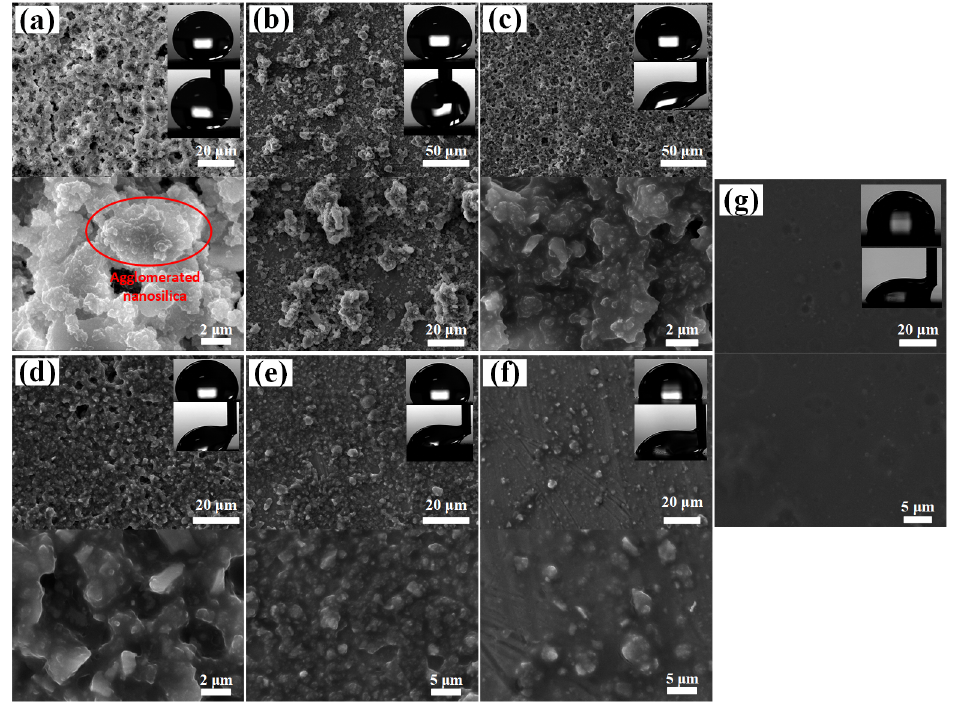
Figure 8. SEM images of the nano / microsilica-filled A-PDMS-modified epoxy coatings: ( a ) R n / m = 10:0; ( b ) R n / m = 8:2; ( c ) R n / m = 6:4; ( d ) R n / m = 4:6; ( e ) R n / m = 2:8; ( f ) R n / m = 0:10. ( g ) A-PDMS-modified epoxy coating. Sessile and moving water drops are shown in the insets.